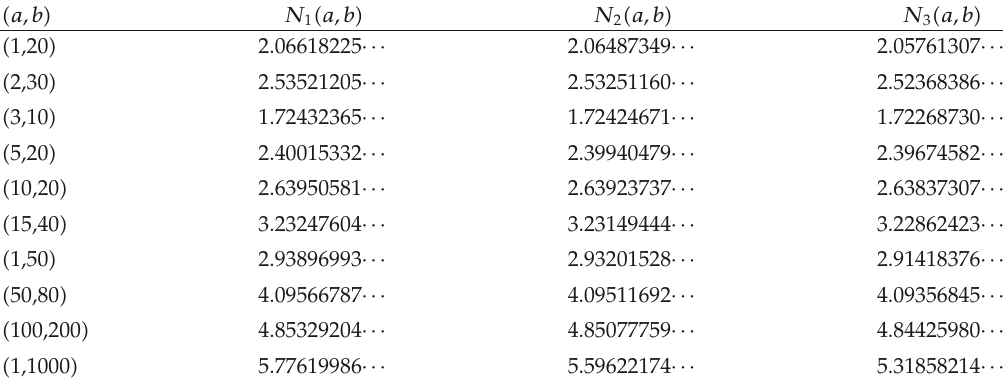
(cid:2) a,b (cid:3) and N 2